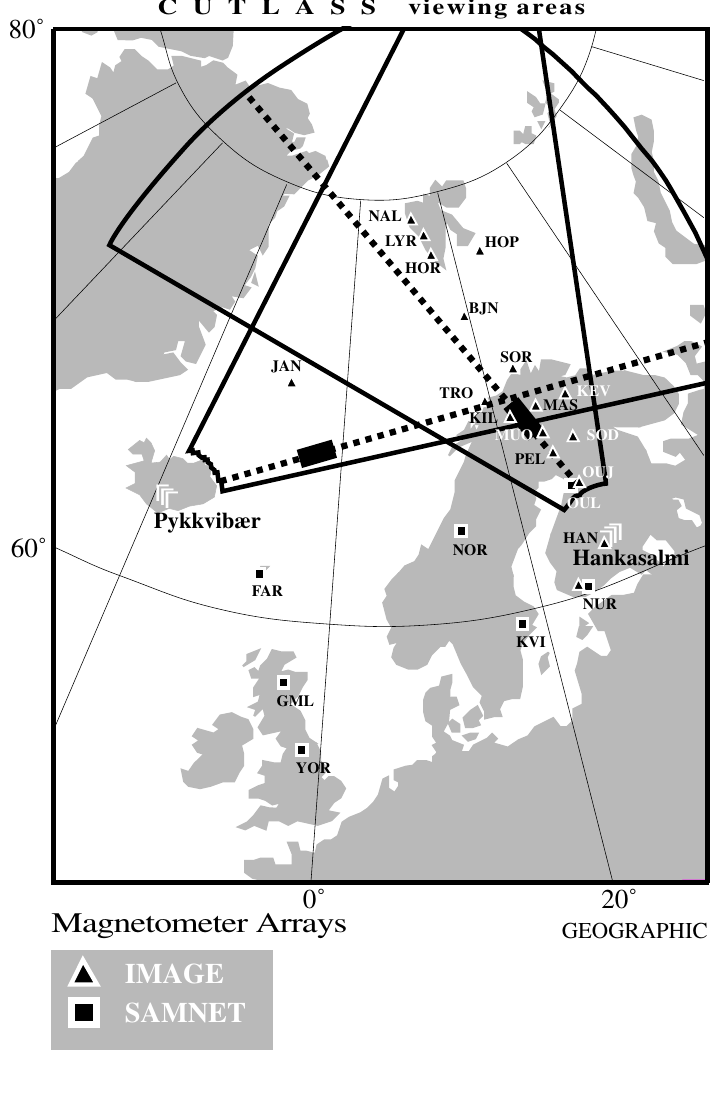
Fig. 1. Map in geographic coordinates showing CUTLASS beams and ranges of interest, and IMAGE and SAM- NET magnetometer locations. Shaded boxes depict ionospheric reflection re- gions for ground scatter recorded by beam 6 of the Finland radar and beam 14 of the Iceland East radar. The DOPE Doppler sounder was located just east of Tromsø, and the IRIS imaging ri- ometer at